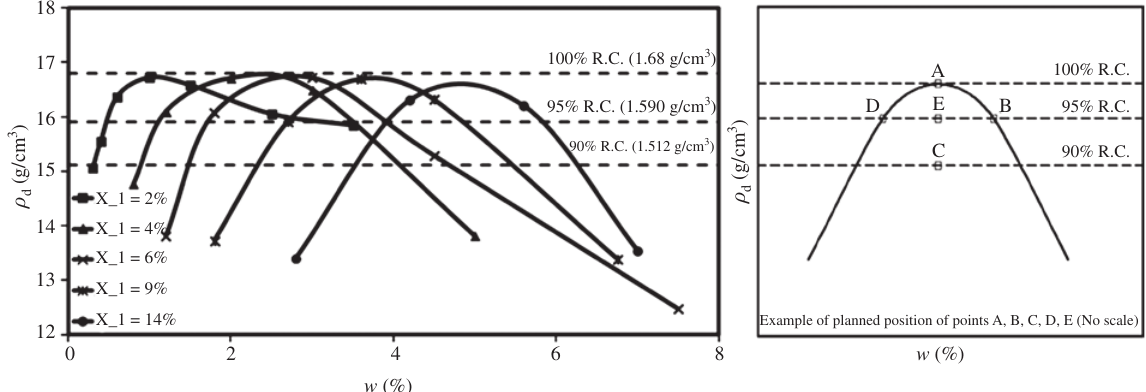
Figure 2 Summary of standard Proctor